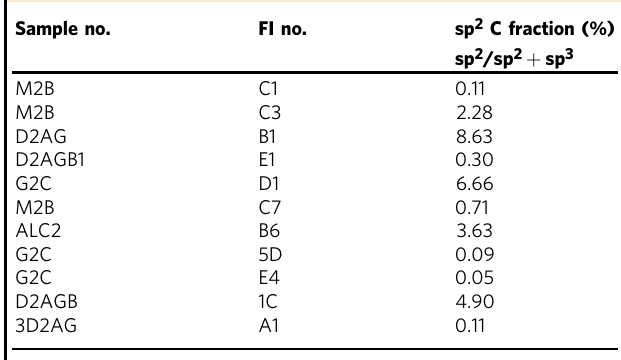
Table 3 Calculated fraction of disordered sp 2 -structured carbon in diamonds Sample